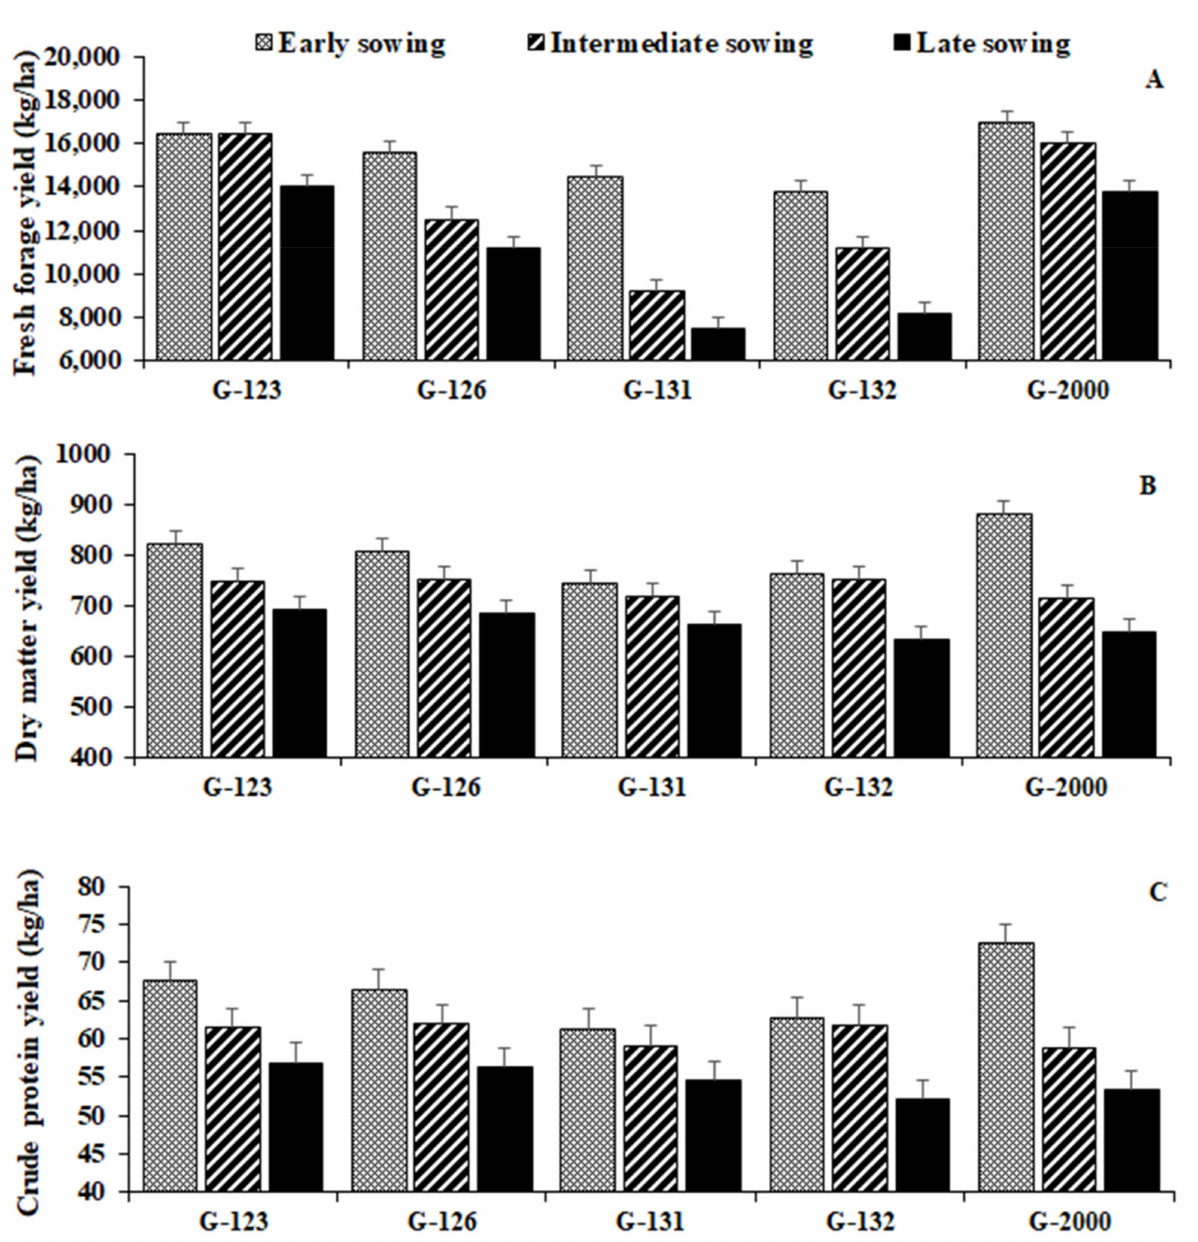
Figure 1. Influence of sowing date on fresh forage yield ( A ), dry matter yield ( B ), and crude protein yield ( C ) of five barley genotypes under salinity conditions averaged over the two growing seasons. Table 3. Impact of sowing date and production system on forage yield, forage quality, grain yield, and yield